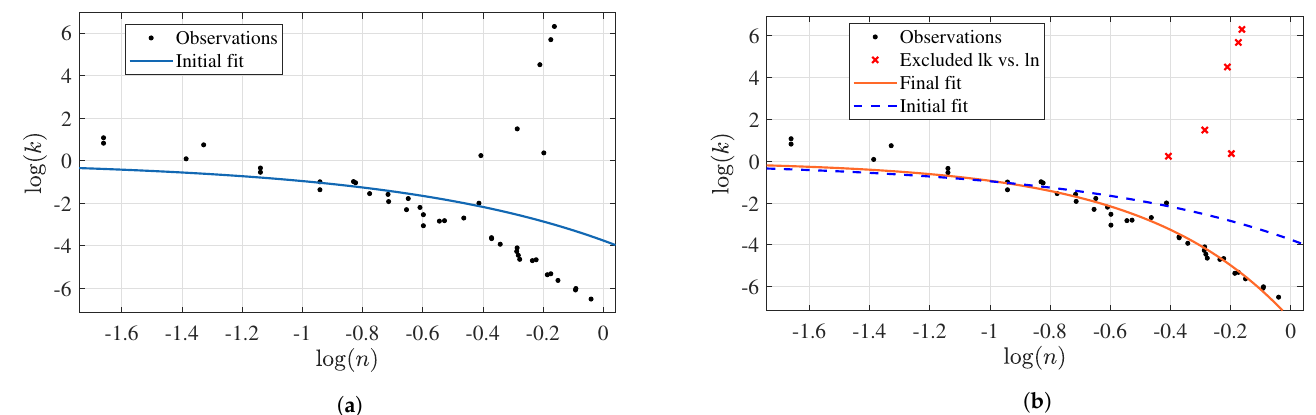
Figure 13. Exponential regression results of log ( k ) and log ( n ) for the XG dataset: ( a ) initial fitting and ( b ) fitting after